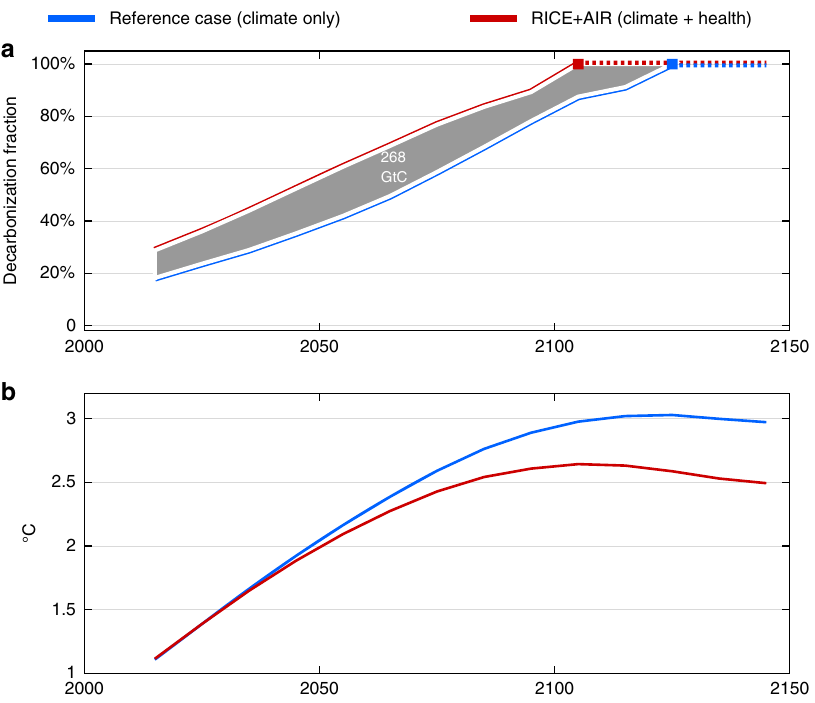
Fig. 1 Optimal decarbonization and temperature. a Decarbonization over time for the reference case optimal policy that excludes health co-bene fi ts (blue line) and in the full RICE + AIR optimal policy that includes health co-bene fi ts (red line). b Estimated global temperature rise above preindustrial levels that would occur given the decarbonization in a . Decarbonization is relative to a business-as-usual scenario without any climate action, and